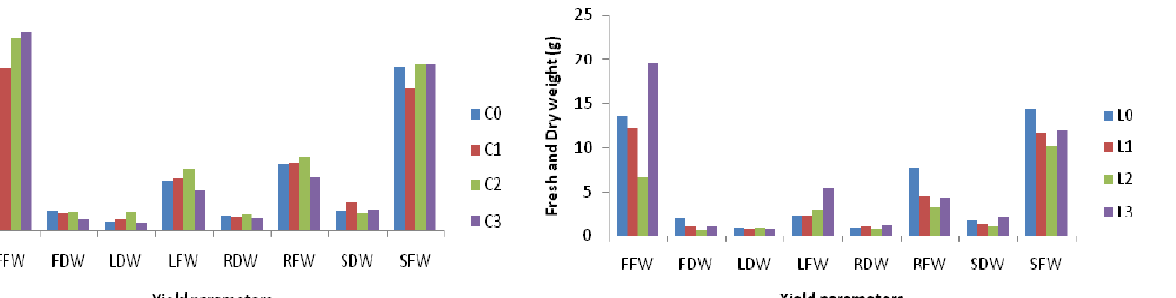
Fig. 3. Effect of light intensities on the yield parameters of two cultivars of okra in the pot experiment The values are the mean of the two maize varieties under different light intensities; L0-Control/No reduction; L1- 33% light reduction; L2- 46% light reduction; L3- 76% light reduction; FFW = Fresh Fruit Weight; FDW = Fruit Dry Weight; LDW = Leaf Dry Weight; LFW = Leaf Fresh weight; RDW = Root Dry Weight; RFW = Root